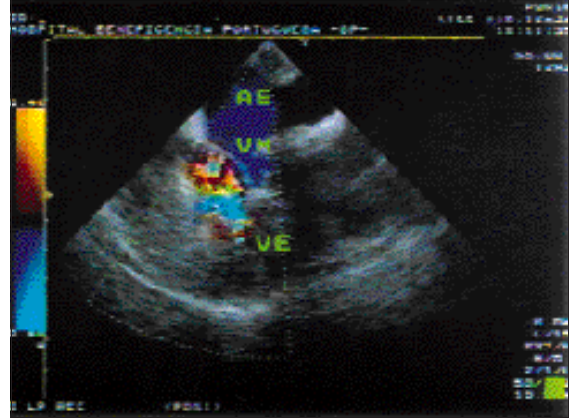
Fig. 9 – Ecocardiograma transesofágico intra-operatório. Corte transver- so mostrando retalho de pericárdio bovino formando a nova parede posterior do átrio esquerdo, com exclusão da região